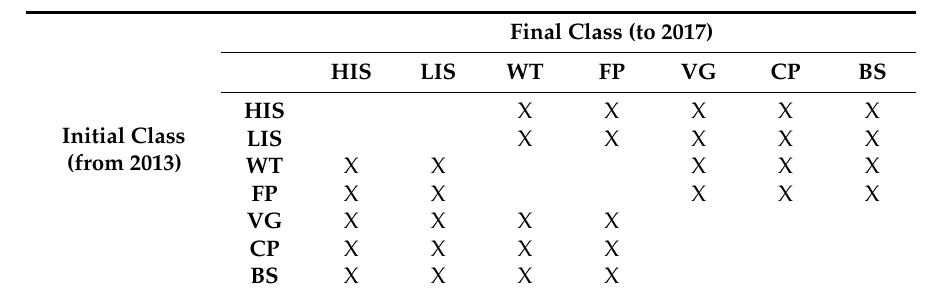
Table 2. The “from-to” land cover change matrix (IS, impervious surface; WT, water; FP, fishing ponds; VG, vegetation; CP, crop; BS, bare